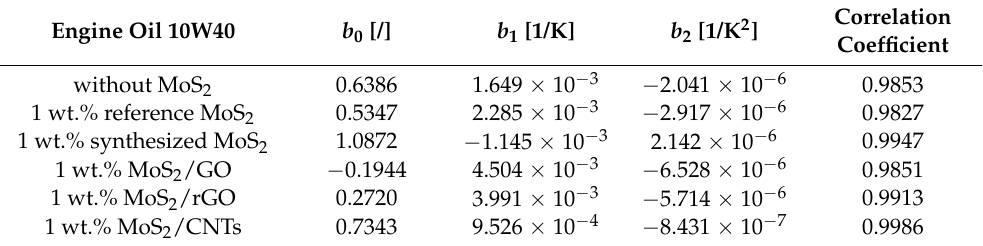
Table 4. Polynomial coefficients in Equation (14) for the oil flow behavior index.